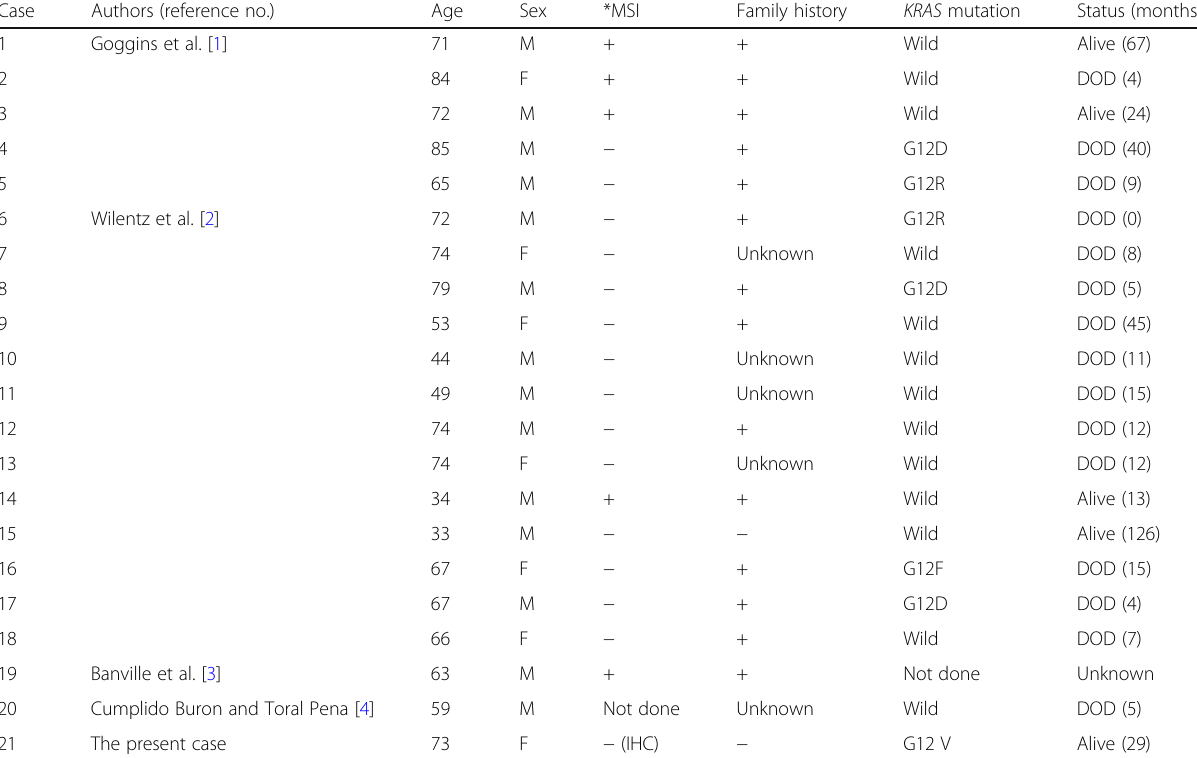
Table 1 Literature review of clinical and genetic characteristics of 21 medullary carcinomas of the pancreas Case Authors (reference